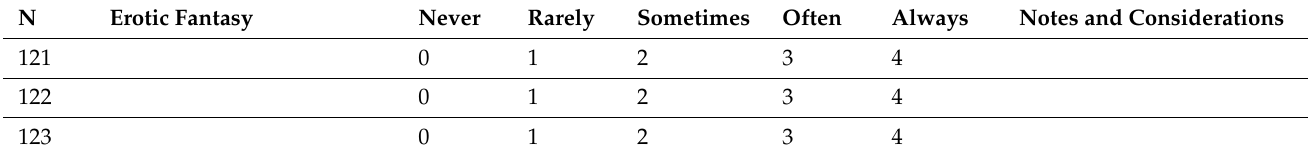
Table A2. Questionnaire.